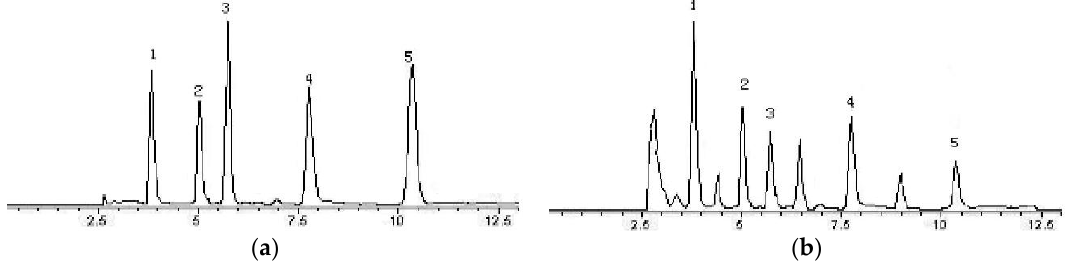
Figure 4. Chromatograms of chemical reference substances ( a ) and sample ( b ) in 360 nm (1—Apigenin-7- O - β - D -neohesperidoside ( 3 ); 2—kaempferol-3- O - β - D -glucopyranosyl-7- O - β - D -glucopyranoside ( 4 ); 3—kaempferol-7- O - β - D -glucopyranoside ( 5 ) 4—apigenin-7- O - β - D -glucopyranoside ( 2 ); 5— dihydrokaempferol ( 1 )). Table 3. Results of the determination of samples (mg · g − 1 ).